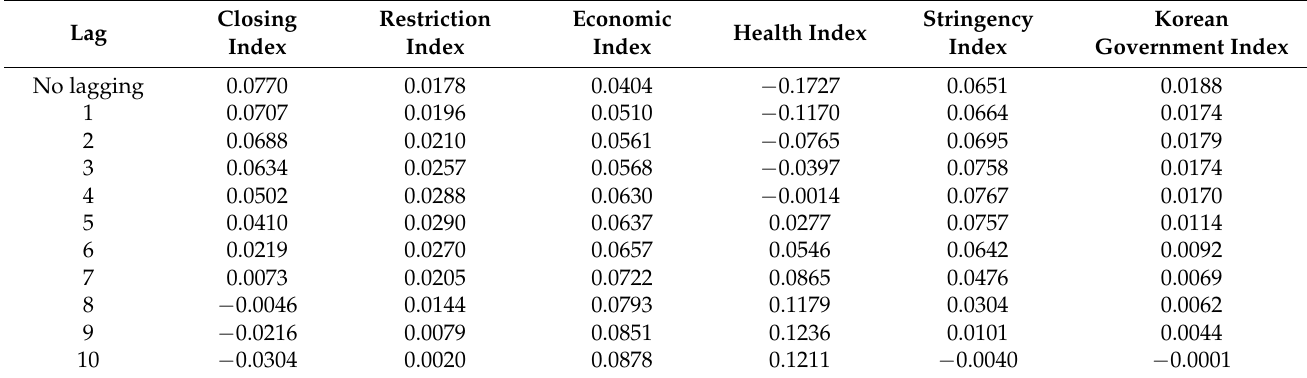
Table 7. Domestic Coefficients from Single Index Model.